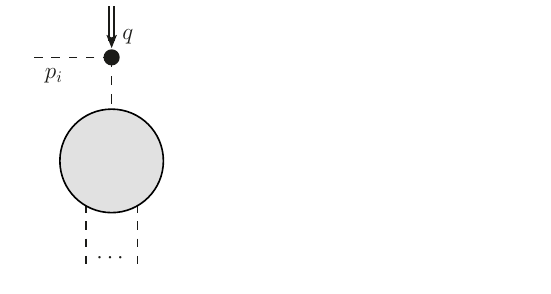
Figure 4 . The only possible kind of diagrams that develops a pole for soft q in R . As p i is on-shell, this kind of diagrams gives the propagator i/ (2 p quadratic in π